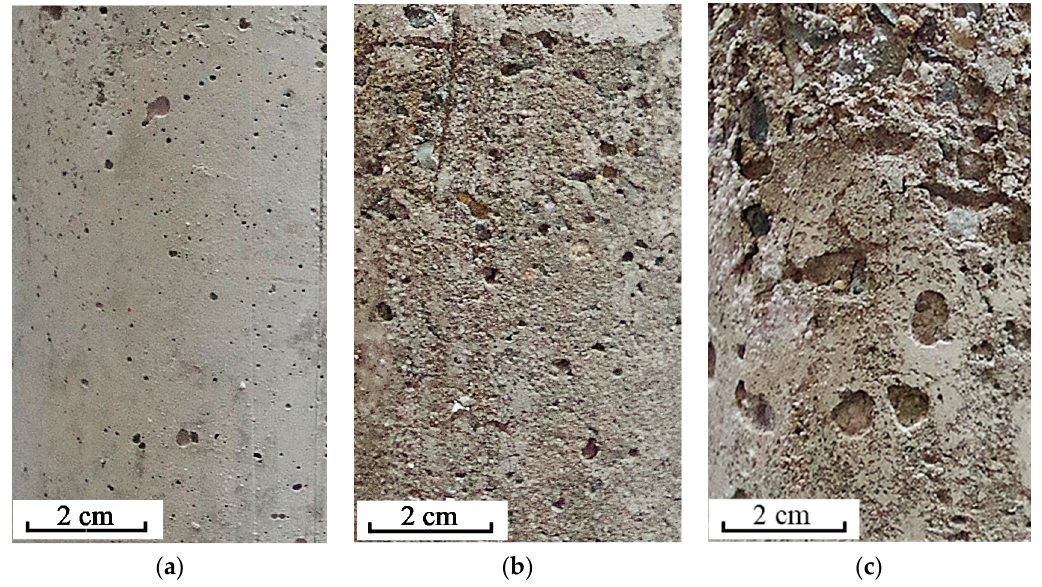
Figure 6. Surface photos of specimens with different water/cement ratios: ( a ) 0.40, ( b ) 0.48, and ( c ) 0.55.